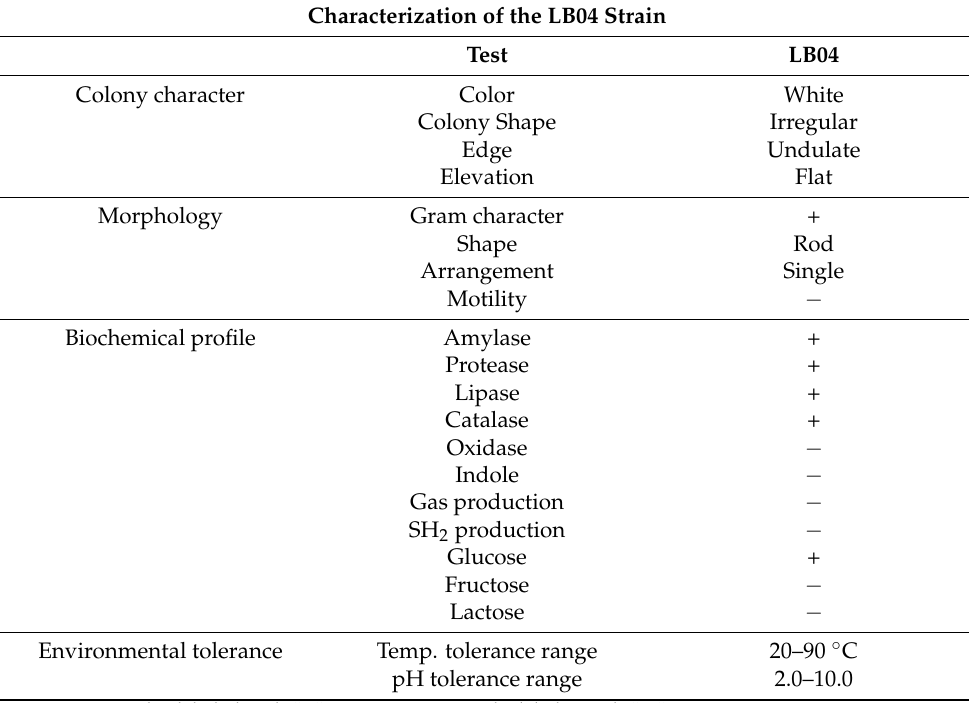
Table 1. Identification profile of Bacillus licheniformis strain LB04. Characterization of the LB04